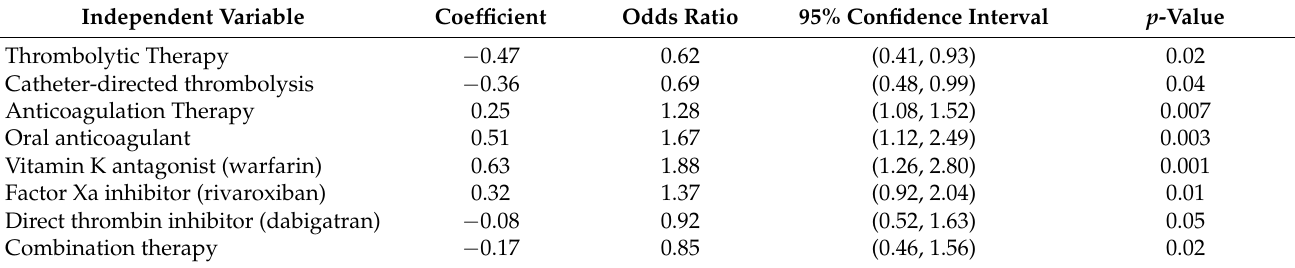
Table 5. Multiple logistic regression analysis of the effect of different therapies on